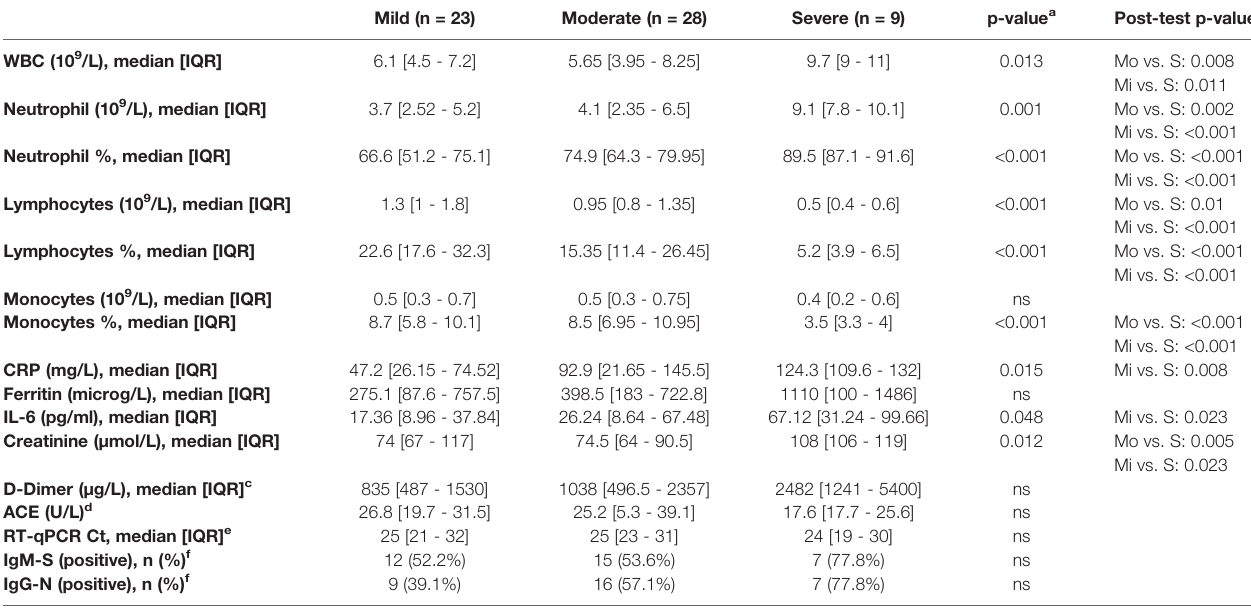
a Kruskal-Wallis test for comparison between continuous variables. b Dunn post-test with Bonferroni correction, Mi, mild; Mo, Moderate; S, Severe. c Missing data for 1 mild patient. d Missing data for 2 mild patients. e Missing data for 2 mild patients and 2 moderate patients. f Missing data for 4 mild patients, 3 moderate patients and 1 severe patient. IQR, interquartile range; Mild, modi fi ed WHO score = 4; Moderate, modi fi ed WHO score = 5; Severe, modi fi ed WHO score ≥ 6 ns, non signi fi